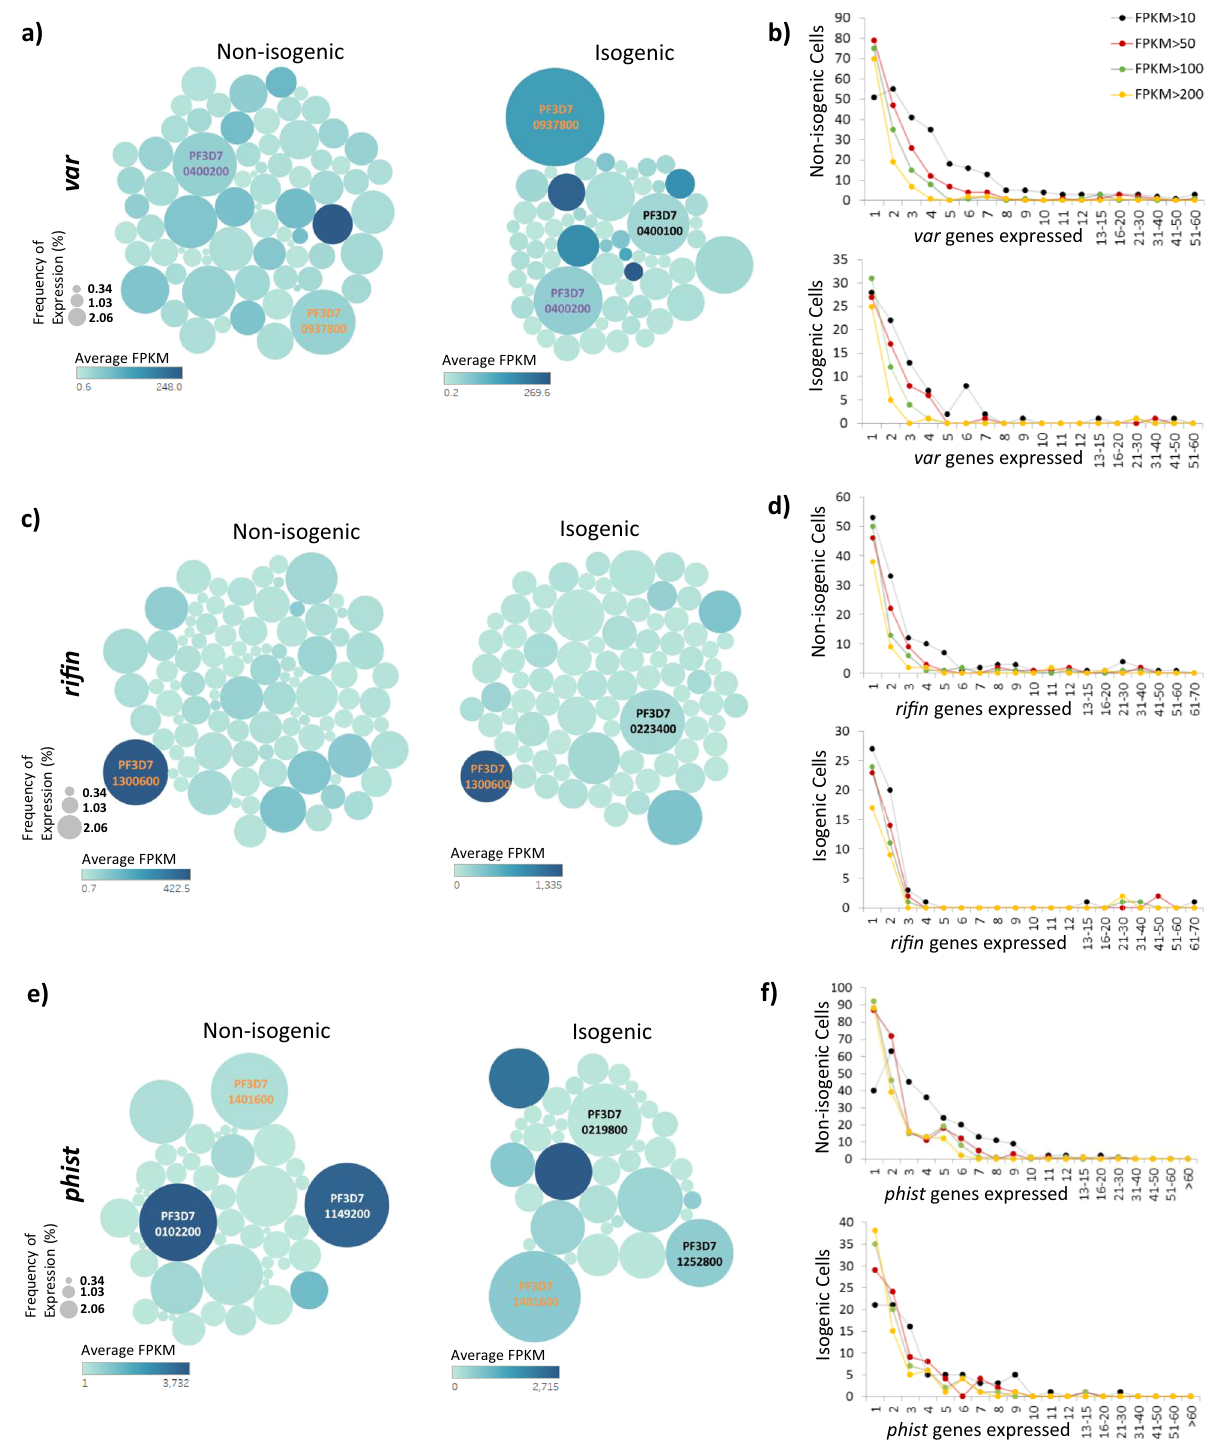
Fig. 4 Transcriptional pro fi le of variant surface antigen encoding genes. Bubble plots depicting the frequency of expression and average expression (FPKM) for a var , c ri fi n and e phist genes in both non-isogenic and isogenic schizonts with same gene IDs highlighted in same colour in the two parasite groups. A distribution of number of b var , d ri fi n and f phist transcripts expressed per cell is shown as a line plot for non-isogenic and isogenic parasites. Different colours represent the distribution of transcripts expressed above 10 (black), 50 (red), 100 (green) or 200 (yellow) FPKM in individual schizonts. Source data are provided as a Source Data fi